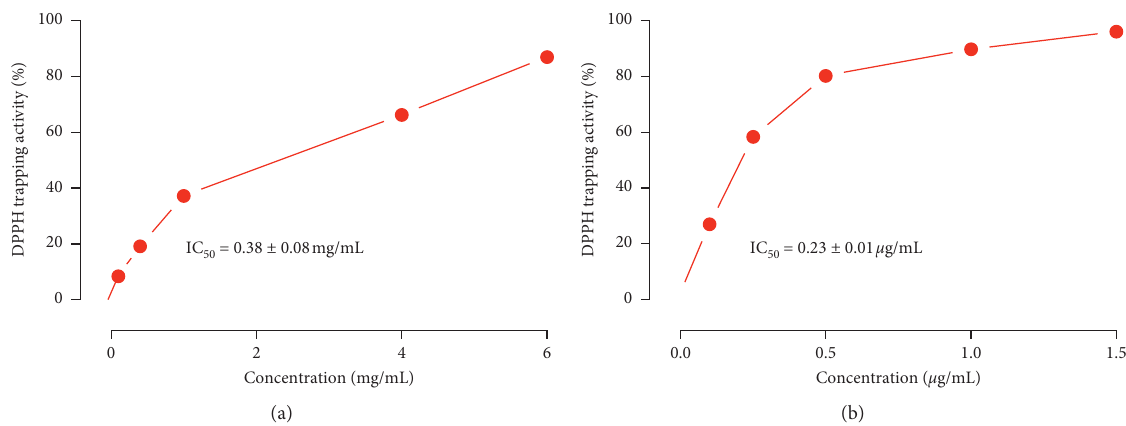
Figure 1: Effect on DPPH scavenging by ODSO (a) at various concentrations. Ascorbic acid (b) was used as a standard antioxidant, ( n � 3); ODSO, O. dillenii seeds oil.